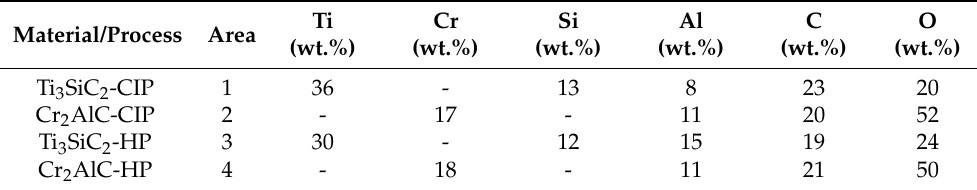
Table 7. An EDS area analysis of the wear tracks produced with a load of 10 N shown in the micrographs in Figure 17 for cold isostatic pressing (CIP) and hot-pressed (HP) samples of the Ti 3 SiC 2 and Cr 2 AlC MAX